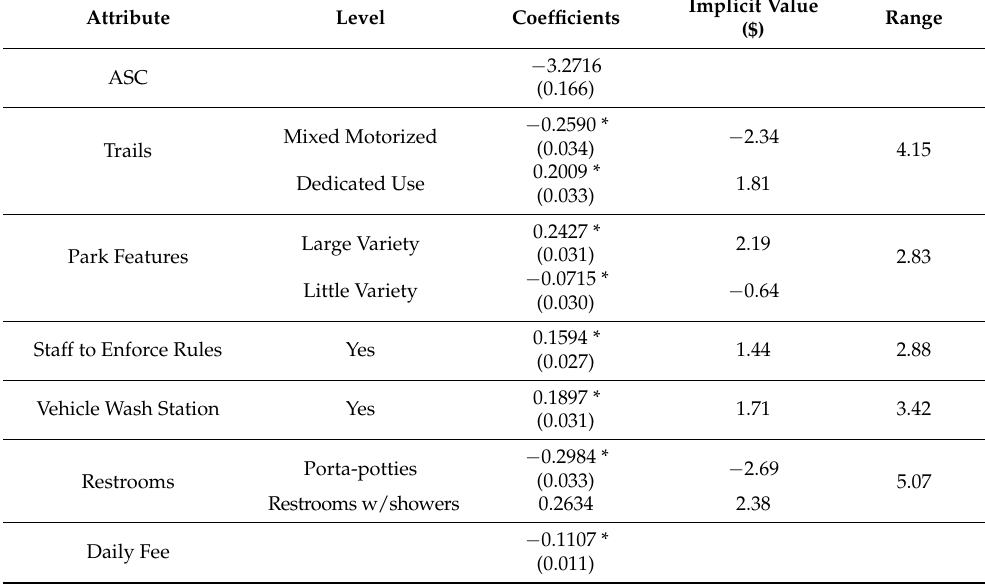
Table 1. Summary of choice model findings for all respondents (n =